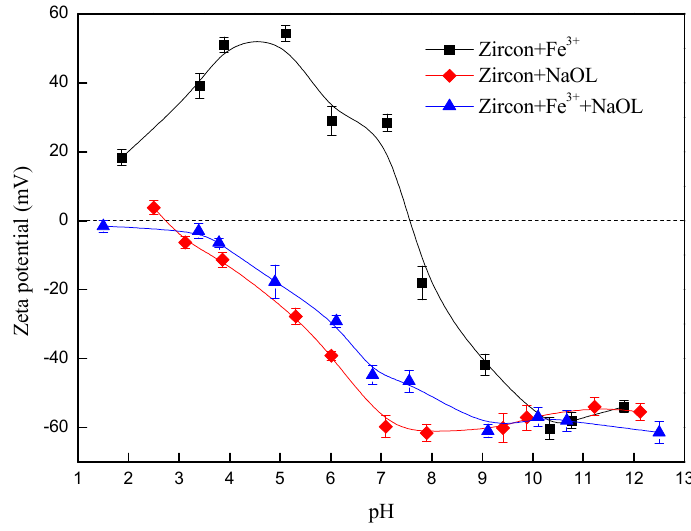
Figure 12. Zeta potential of zircon as a function of pH in the presence of Fe 3+ and/or NaOL (Fe 3+ : 8 × 10 − 5 mol/L; NaOL: 4 × 10 − 4 mol/L).